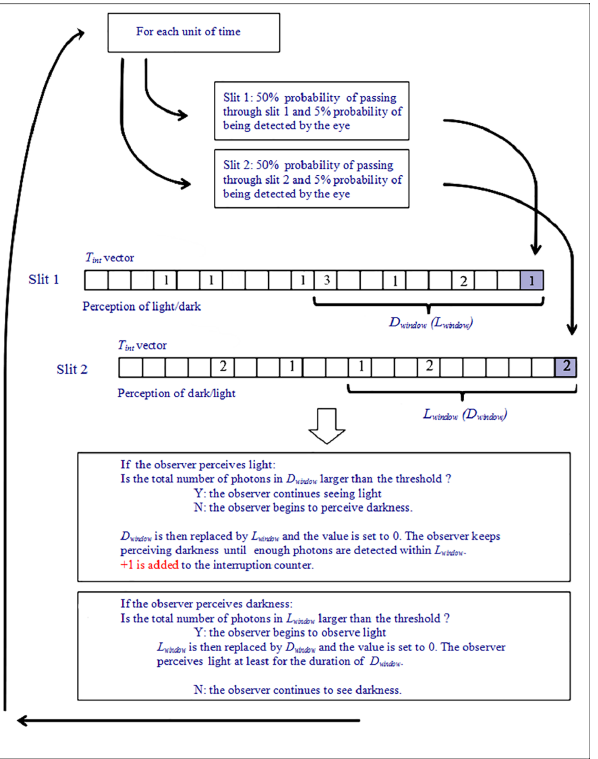
Fig 8. Process diagram of simulation algorithm and rationale. A time vector models the integration time T int related to the observation of each slit. Each cell in the vector represents one unit of time. If, within a certain unit of time, i photons are detected by the retinal rods, we write i in the cell that corresponds to that unit of time. The interruption counter is increased depending on the total number of photons present in the observer ’ s D window and L window .